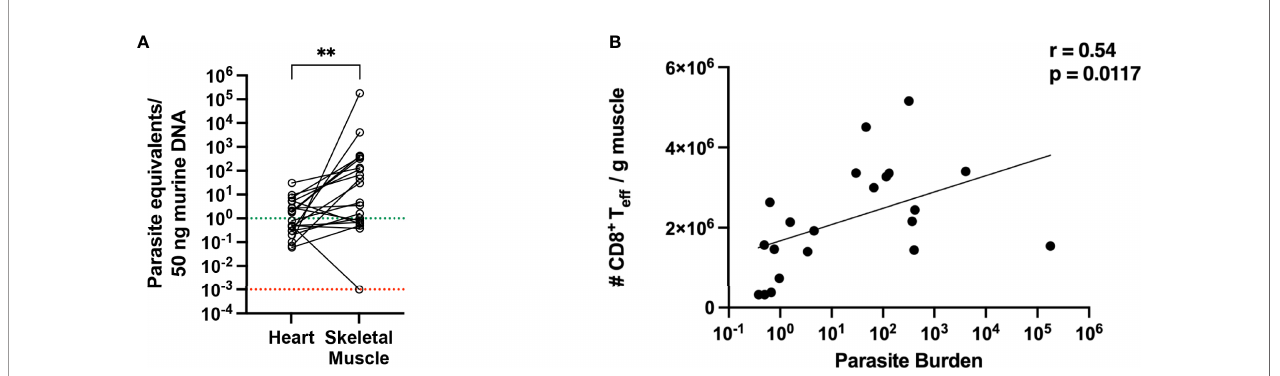
FIGURE 6 | Parasitic burden in muscle tissue is higher than in heart tissue and shows a positive correlation with the number of activated CD8 + T cells. (A) Parasite equivalents per 50 ng DNA were analyzed from heart and muscle tissues at 800 dpi of infection by qPCR. Data were pooled from two independent experiments